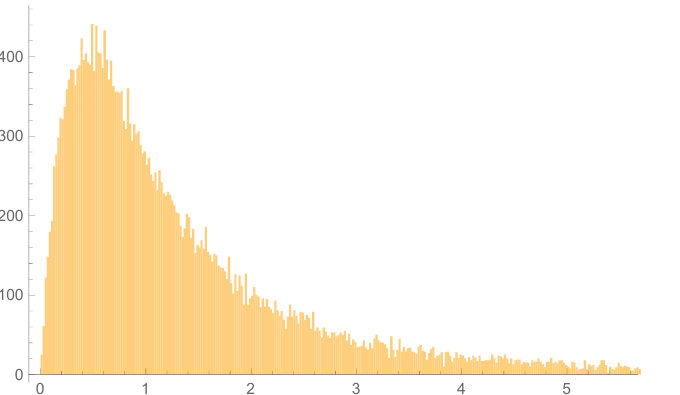
Figure 14 . The ratio of the distances between nearest eigenvalues for the upper block of the SYK hamiltonian.